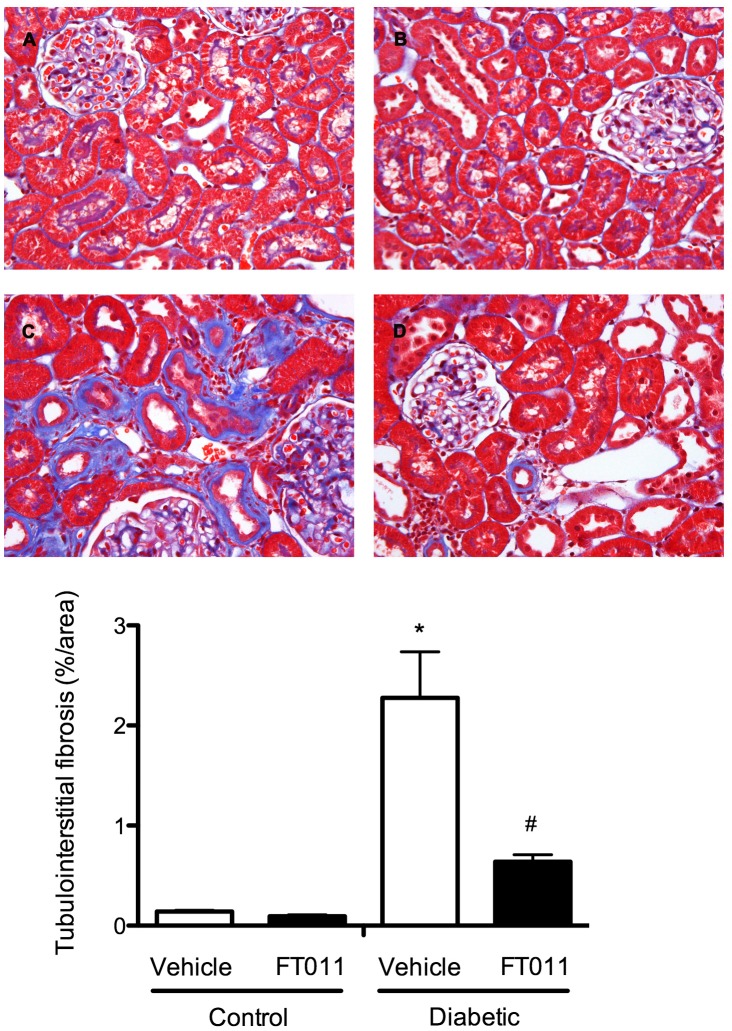
Representative photomicrograph of Masson’s stained sections from diabetic rats.Representative photomicrographs of Masson’s trichrome stained kidney sections from control (A) and control animals treated with FT011 (B), diabetic rats (C) and diabetic rats treated with FT011 (D); compared with control animals, untreated diabetic rats (C) demonstrated severe interstitial fibrosis as blue staining. FT011 treatment in diabetic animals (D) significantly reduced interstitial fibrosis. Magnification, ×400; Quantitative data are expressed as mean ± SEM. *P<0.05 versus control; #
P<0.05 versus vehicle treated diabetic rats.